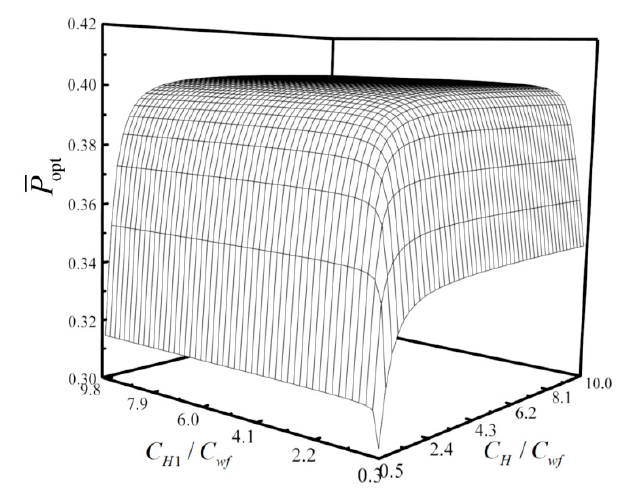
Figure 13. Relationships of P opt versus C H / C wf and C H 1 / C wf